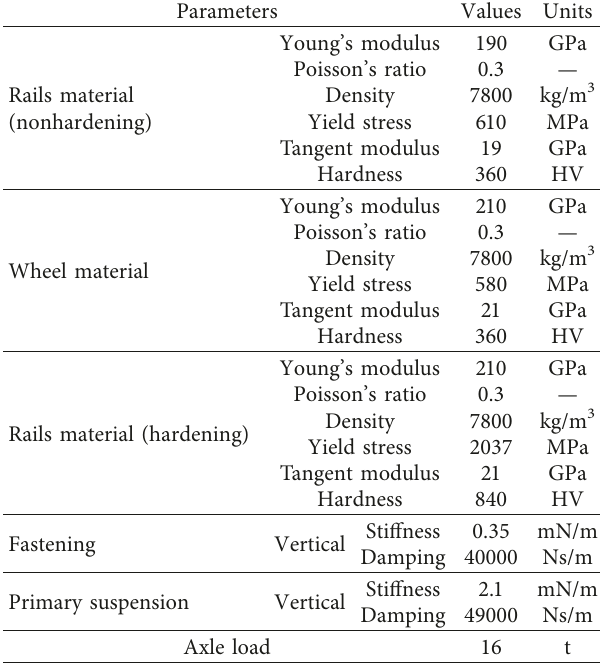
Table 1: The values of parameters used in the